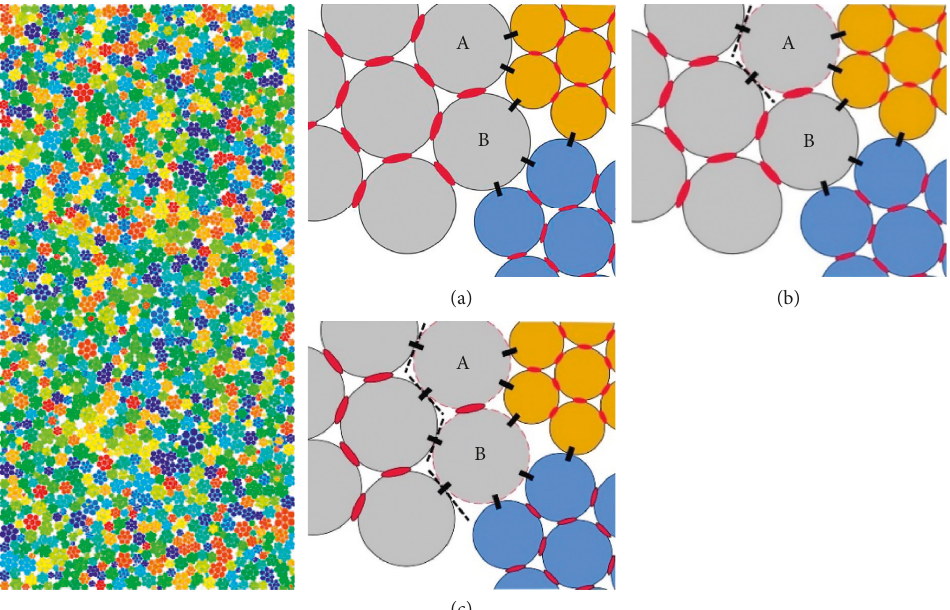
Figure 13: Microcrack evolution of the sand agglomerate: (a) the original agglomerate; (b) the broken agglomerate with cracks around particle A; (c) the broken agglomerate with cracks around particles A and